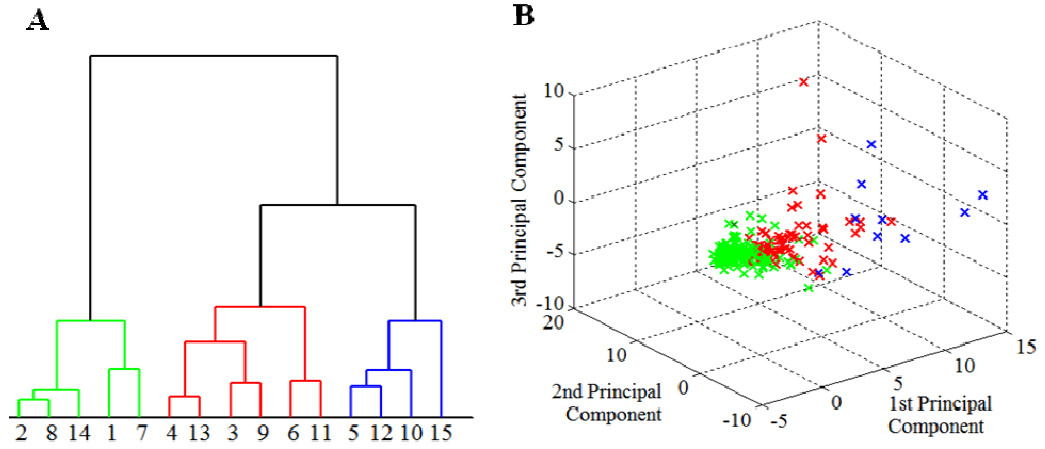
Figure 5. ( A ) Statistical clustering of apricot cultivars according to their polyphenol content. All apricot cultivars were clustered into three clusters; ( B ) Three-dimensional projection of the clusters to distinguish their